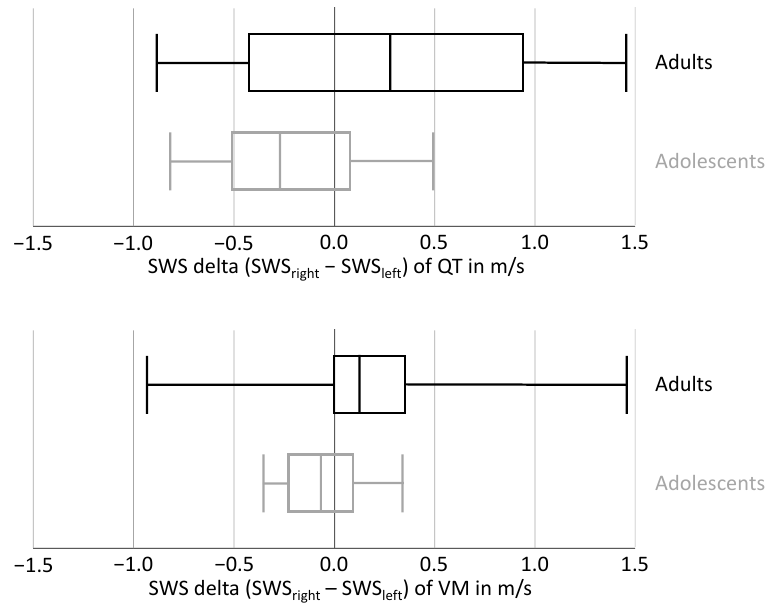
Figure 3. Boxplots of shear wave speed delta (SWS) for adolescent and adult soccer athletes for right and left quadriceps tendon (QT) and medial vastus muscle (MV).